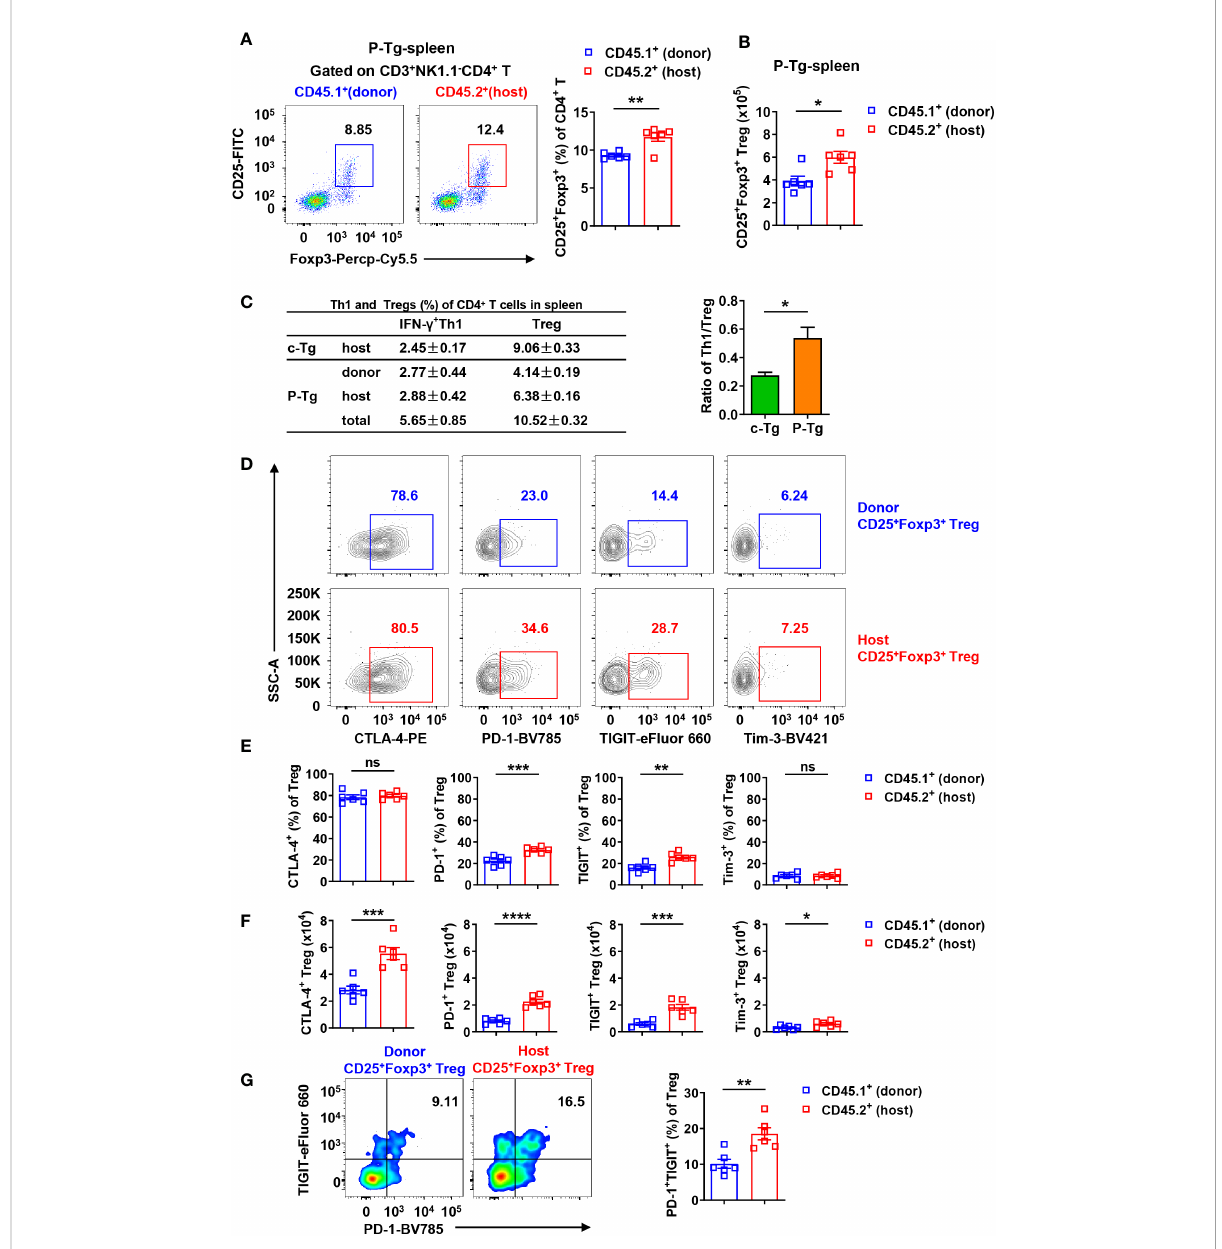
FIGURE 8 Host CD25 + Foxp3 + Tregs were tolerant with higher expression levels of PD-1 and TIGIT in the spleen of HBs-Tg parabionts. WT-HBs-Tg parabiotic mice were generated by parabiosis surgery as shown in Figure 1A. Splenic MNCs were isolated from Tg and P-Tg mice for fl ow cytometry analysis after 4 weeks of parabiosis. (A) Donor CD45.1 + CD3 + NK1.1 - CD4 + T cells and host CD45.2 + CD3 + NK1.1 - CD4 + T cells were gated to analyze the proportion of CD25 + Foxp3 + Tregs in the spleen of P-Tg mice. (B) The number of donor and host CD25 + Foxp3 + Tregs in the spleen of P-Tg mice. (C) The frequencies of donor or host IFN- g + CD4 + T cells (Th1) and CD25 + Foxp3 + Tregs among total CD4 + T cells in the spleen of Tg and P-Tg mice. Data are shown as mean ± SEM in each group. The ratio of total Th1/Treg in the spleen was compared between Tg mice and P-Tg mice. (D) Representative plots showing the expression of CTLA-4, PD-1, TIGIT and Tim-3 in donor CD4 + CD25 + Foxp3 + Tregs or host CD4 + CD25 + Foxp3 + Tregs in the spleen of P-Tg mice. (E) Statistical analysis of the percentages of CTLA-4, PD-1, TIGIT and Tim-3 on Tregs from (D) . (F) Number of CTLA-4, PD-1, TIGIT or Tim-3 positive Tregs from donor and host in the spleen of P- Tg mice. (G) The coexpression of PD-1 and TIGIT in donor CD4 + CD25 + Foxp3 + Tregs and host CD4 + CD25 + Foxp3 + Tregs in the spleen of P-Tg mice. Data are shown as mean ± SEM. An unpaired two-tailed t-test was used. * P < 0.05; ** P < 0.01; *** P < 0.001; **** P < 0.0001; ns, not signi fi cant. Tg, HBs-Tg control; P-Tg, HBs-Tg